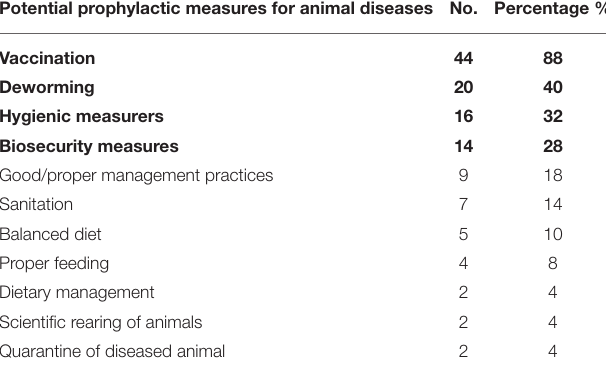
TABLE 5 | Potential prophylactic measures for animal diseases suggested by veterinarians. Potential prophylactic measures for animal diseases No. Percentage %